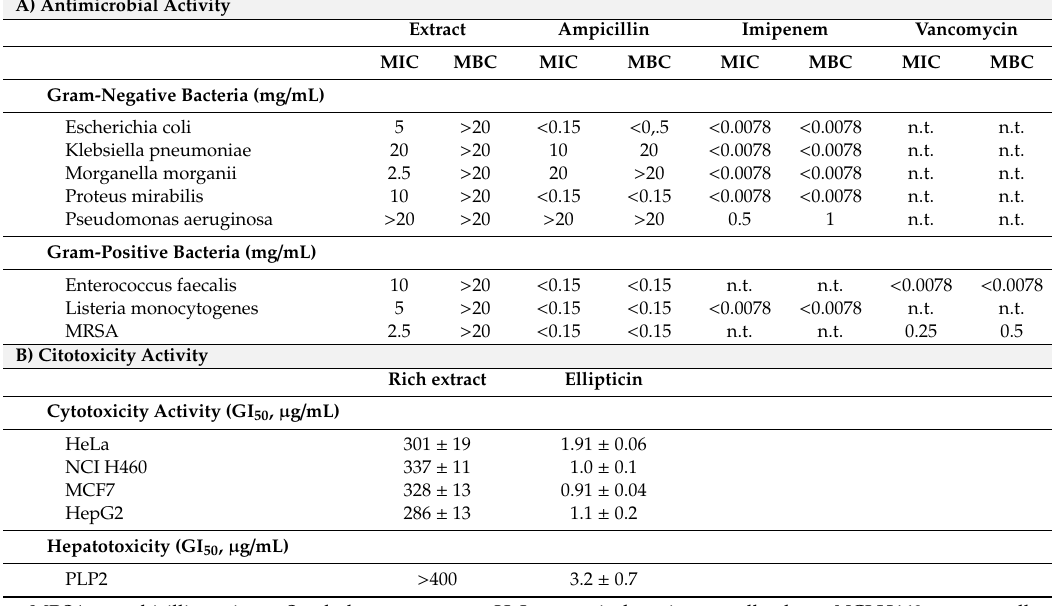
Table 4. Results of antimicrobial and cytotoxicity activities of the rich anthocyanin extract. A) Antimicrobial